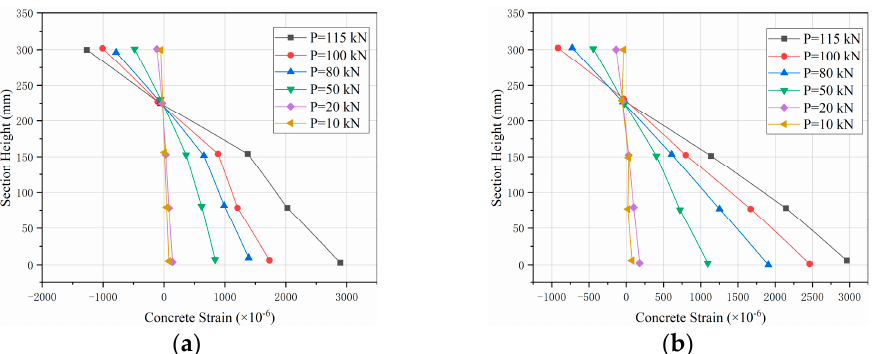
Figure 11. Strain distribution of midspan section along section height. ( a ) C45R50F1, ( b ) C45R50F2.